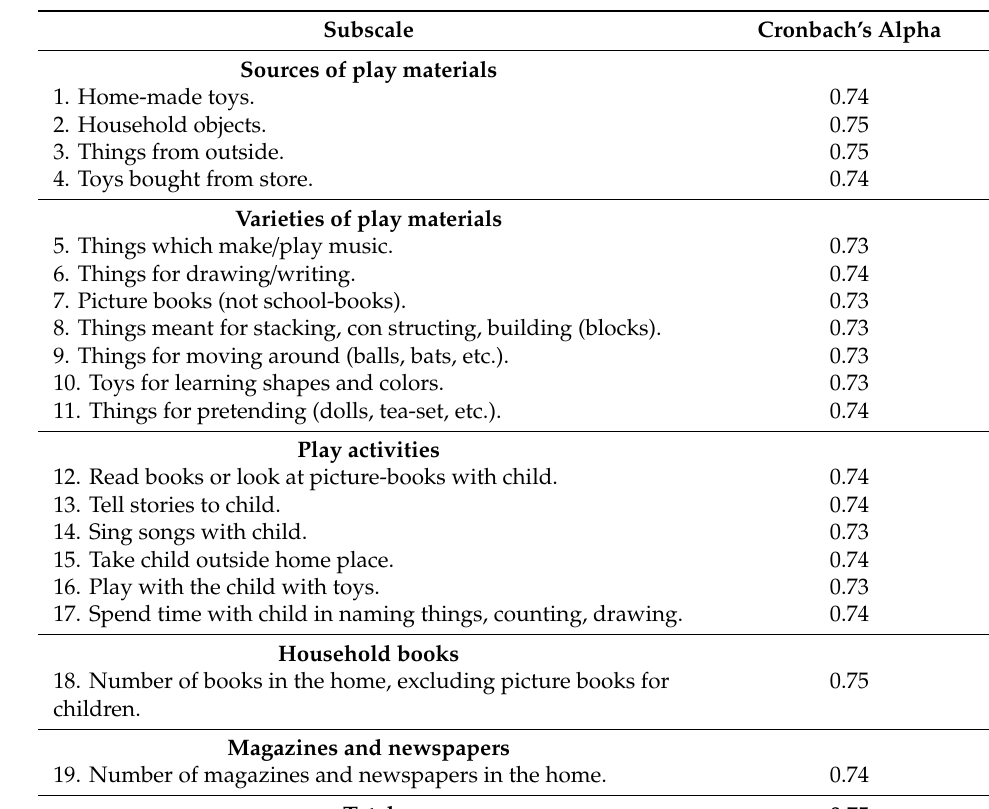
Table A2. Family Care Indicators